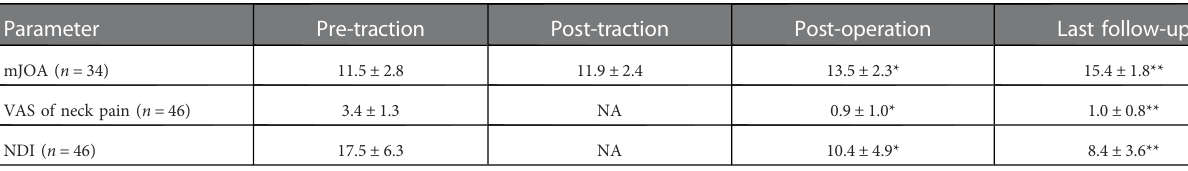
TABLE 3 mJOA, VAS of neck pain, and NDI